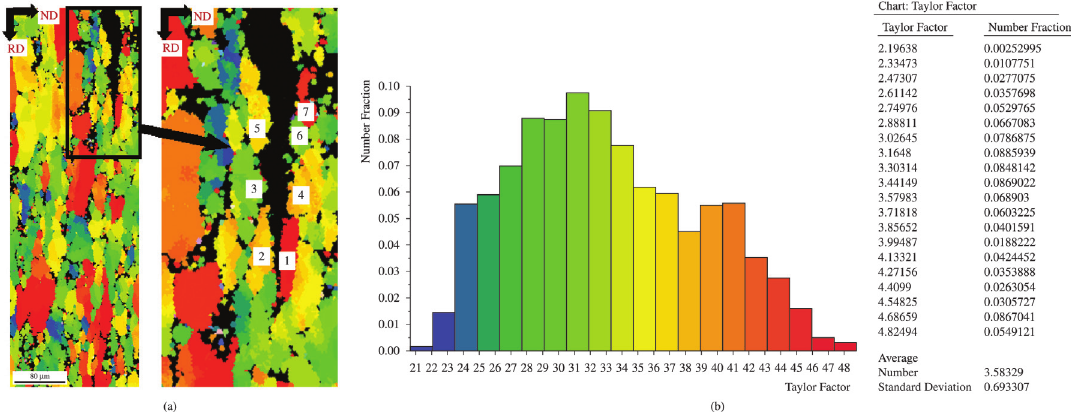
Figure 17. Taylor factor map: a) scan region; b) histogram of number fractions.